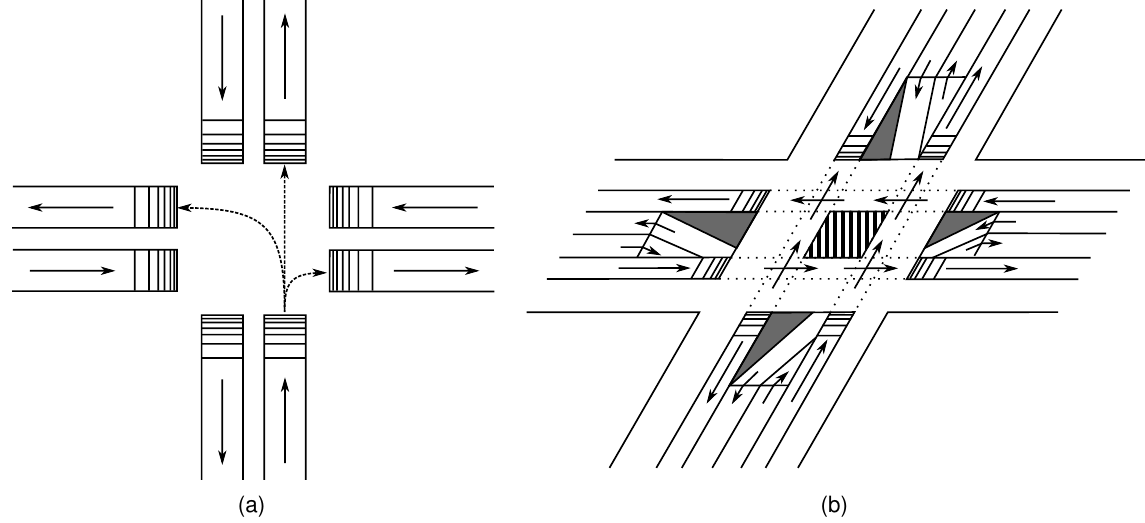
Figure 3. Possible intersection designs: (a) single-layer intersection and (b) multiple-layer intersection with expressways. Adapted from Rojanawisut